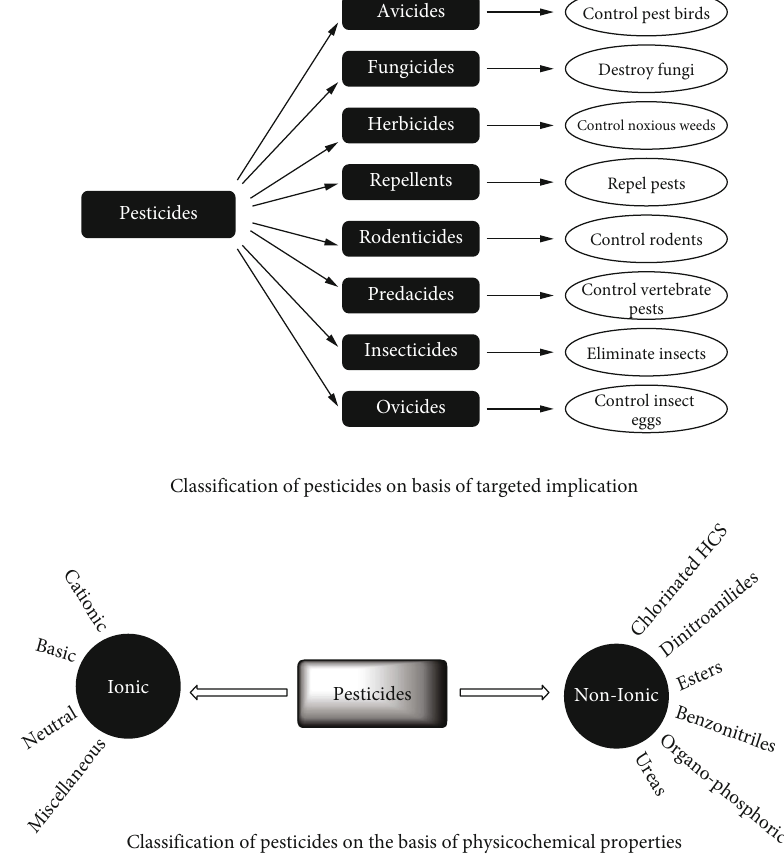
Figure 4: Classi fi cation of pesticides on the basis of targeted implication and physicochemical